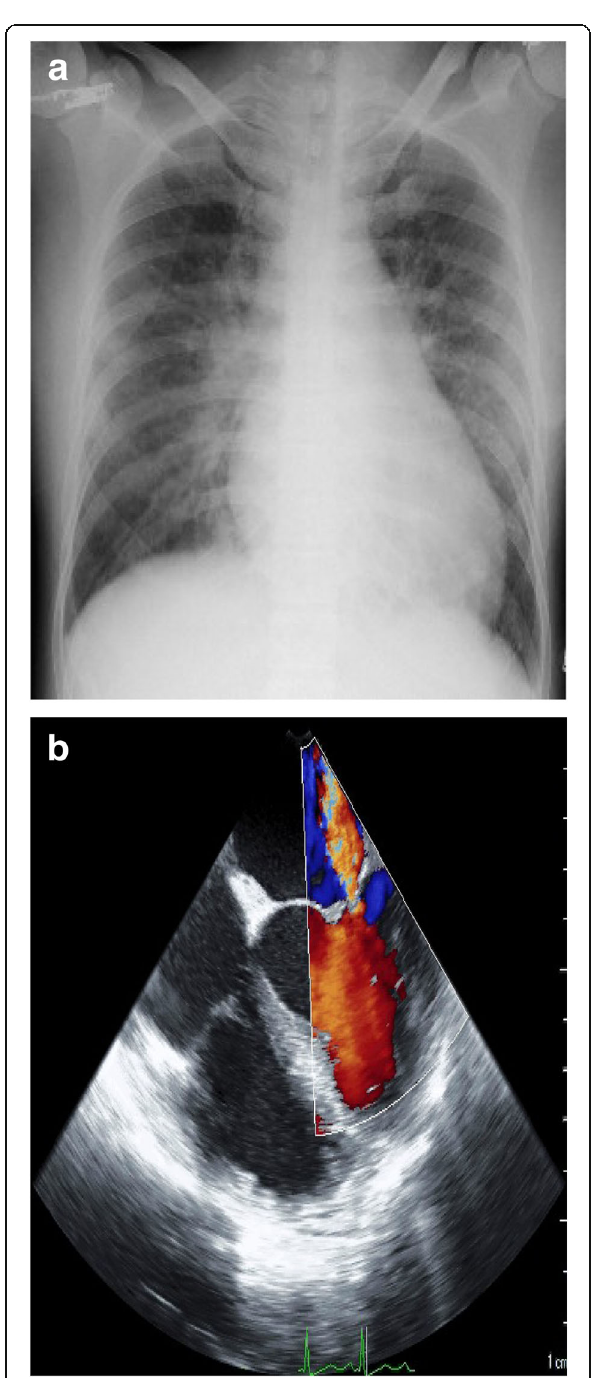
Fig. 2 Examinations after exacerbation of dyspnea. a Chest radiograph showing cardiac enlargement and bilateral pulmonary infiltration. b Four-chamber view of a transesophageal echocardiogram showing severe mitral